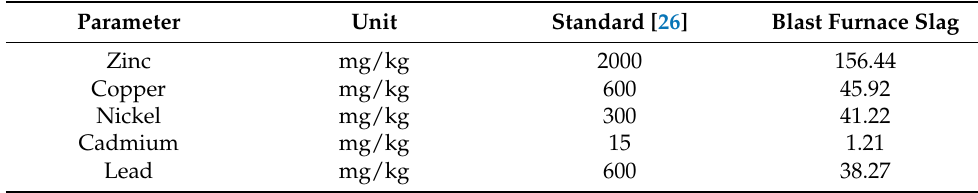
Table 2. The chemical analysis for PTE in Blast Furnace Slag.